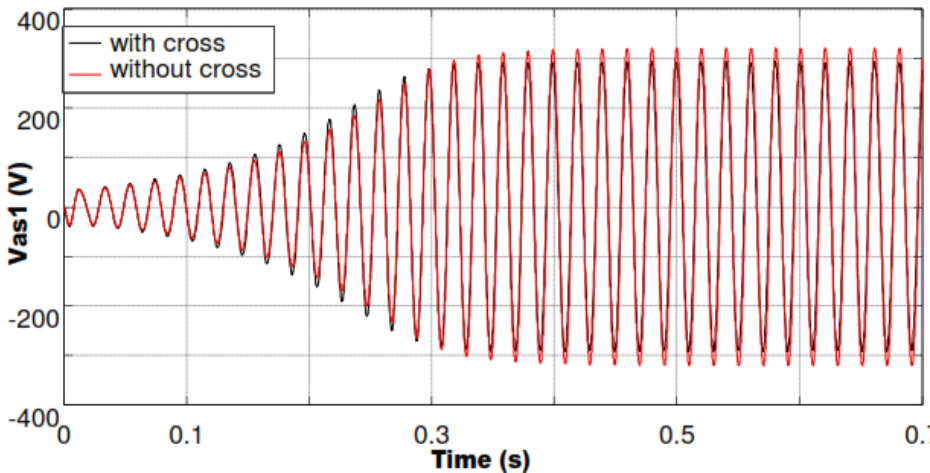
Figure 7. Simulation of the stator voltage Vas1 without and with cross-saturation.